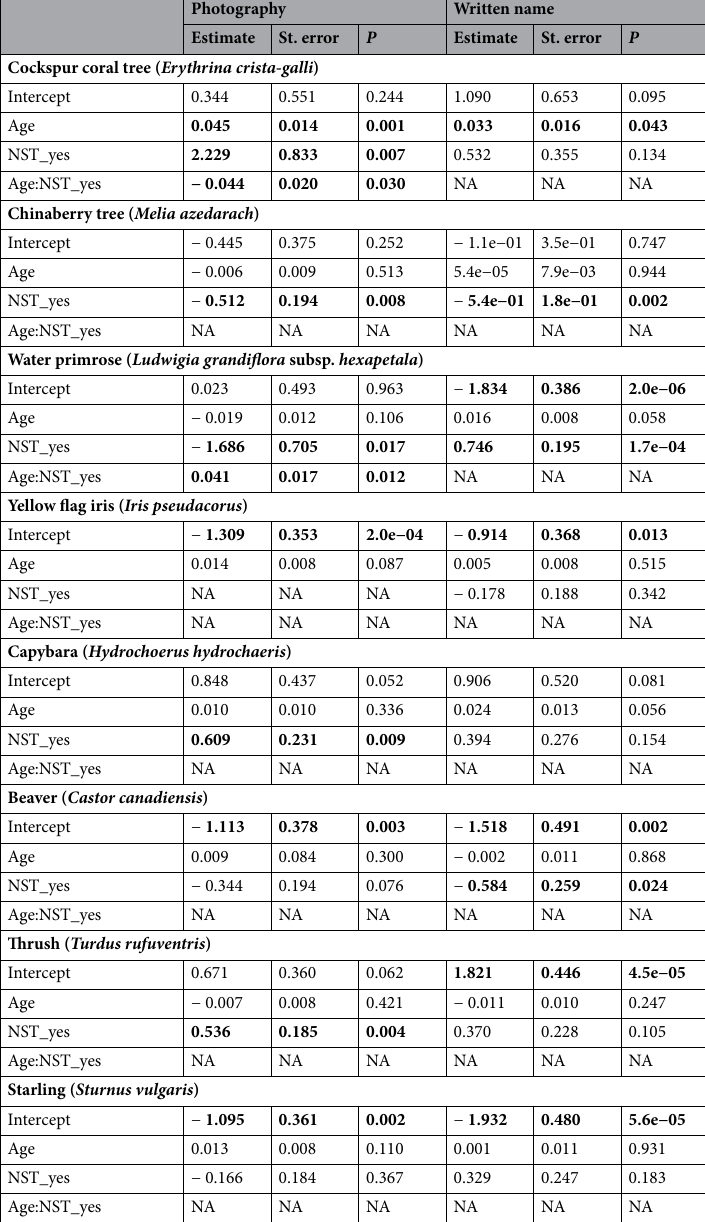
Table 2. Generalised linear model from recognition of native species. Respondents selected native/s species of photos or written names of eight species (four native species-four invasive alien species). Selection of native species (yes or no questions) was modelled considering age and if teachers were or not, Natural Science Teachers (NST). Significant differences are written in